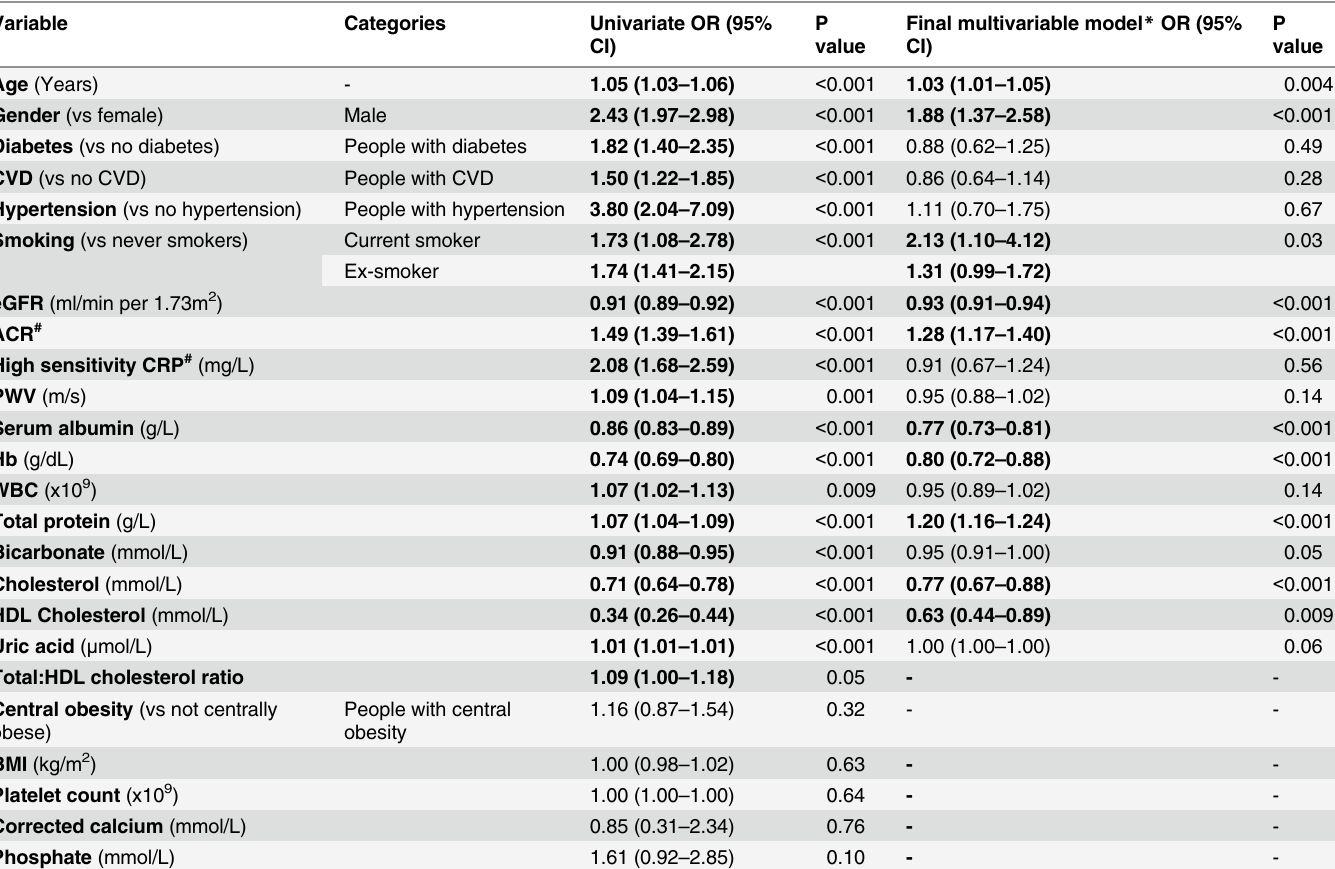
Table 4. Associations of elevated cFLC ( > 43.3 mg/L): univariate and multivariable logistic regression analyses.